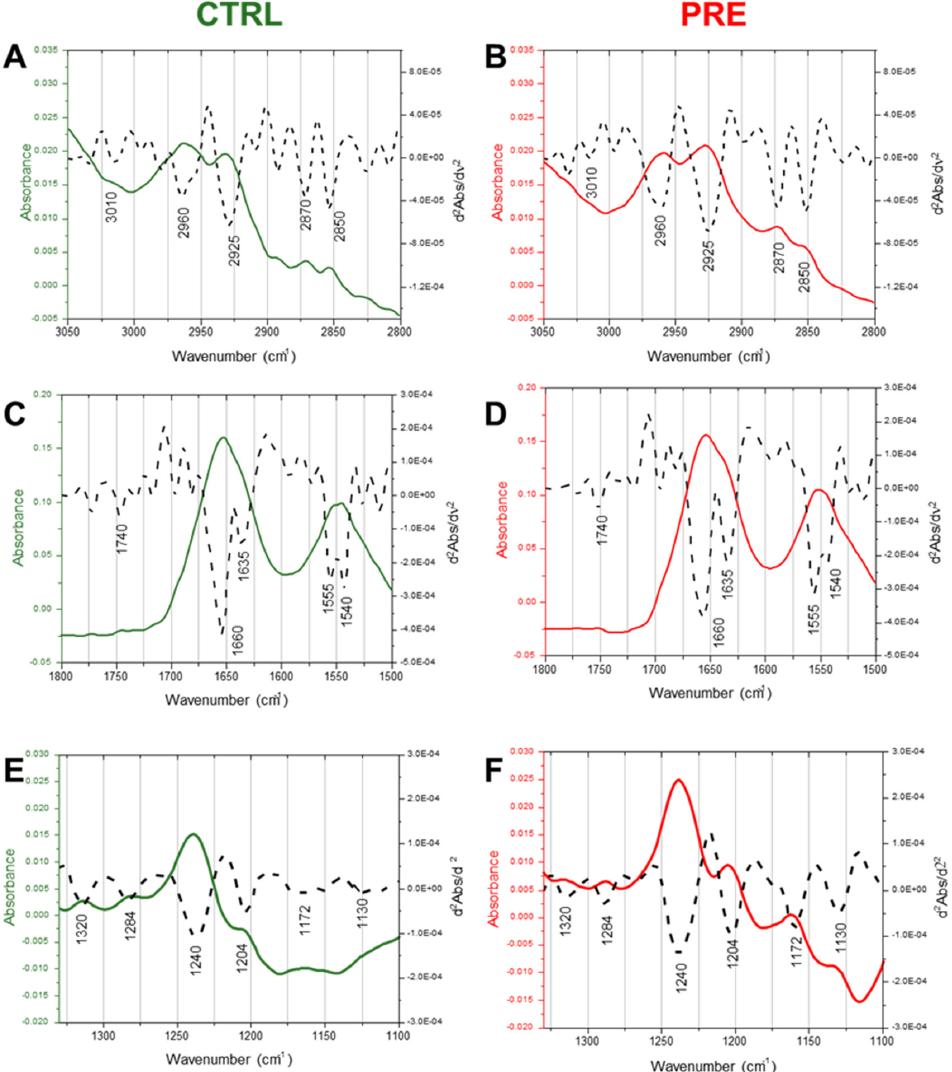
Figure 3. Infrared spectra. Average spectra of control (CTRL, green lines) and pre-eclampsia (PRE, red lines) samples, in the 3050–2800 cm − 1 ( A , B ), 1800–1500 cm − 1 ( C , D ), and 1330–1100 cm − 1 ( E , F ) spectral ranges. Spectra are reported in absorbance (colored continuous lines) and second derivative modes (black dotted lines).